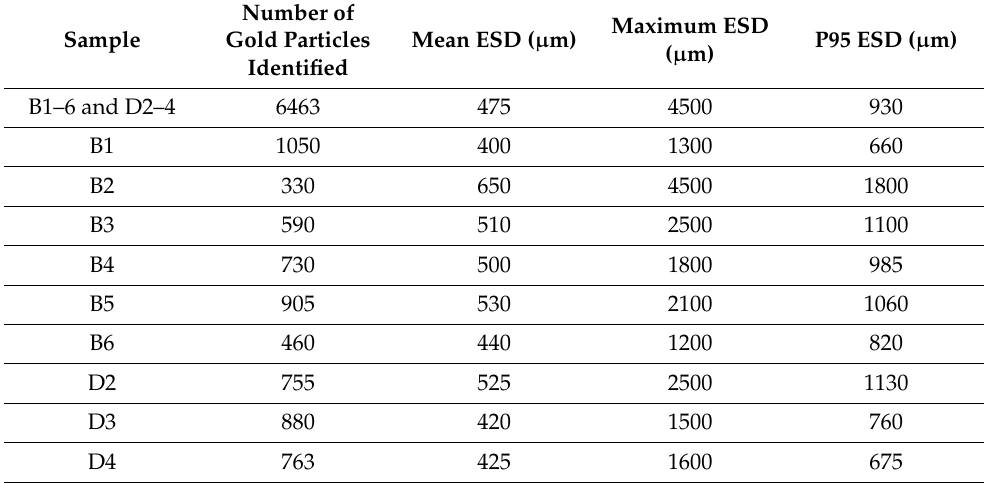
Table 10. Summary of raw (uncorrected for <200 µ m content) gold particle equivalent spherical diameter (ESD) statistics from XCT image